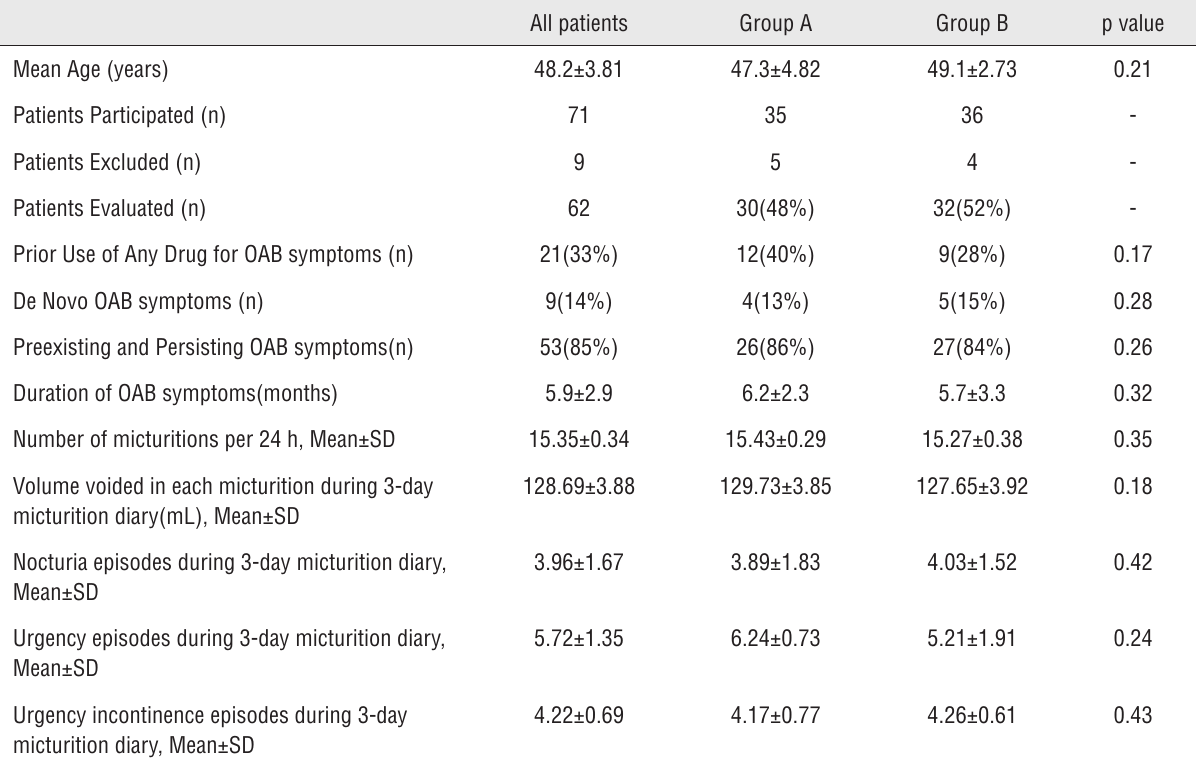
Table 1 - Characteristics and baseline values of study